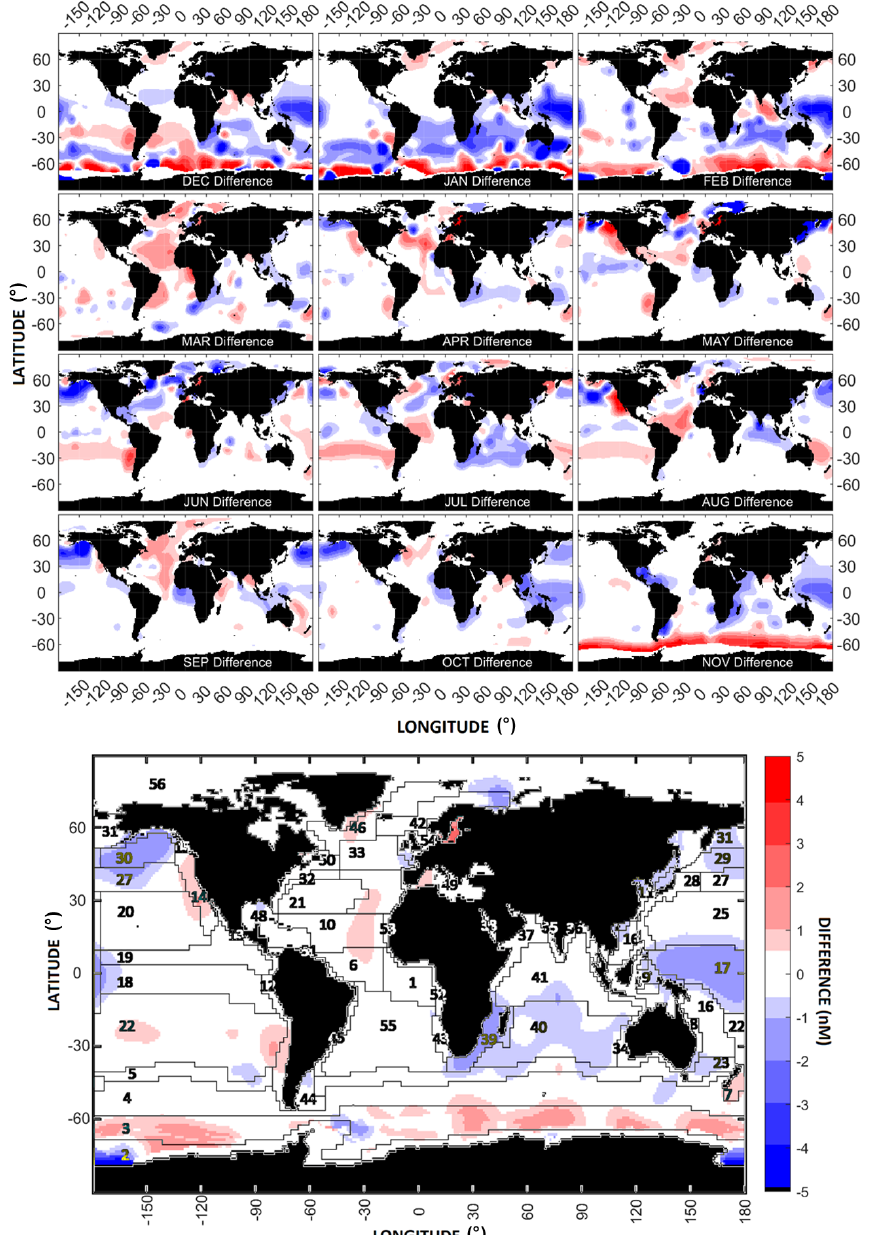
Figure 9. Differences between the monthly and annual mean DMS concentrations of the Rev3 and L11 climatologies (Rev3 − L11).